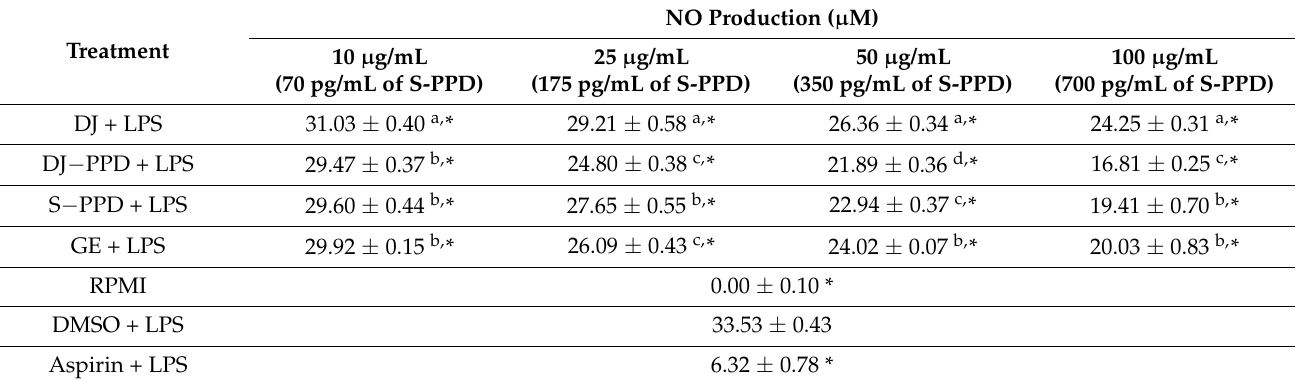
(up to 100 µg/mL (DJ, DJ-PPD, and GE) or 700 pg/mL (S-PPD)).